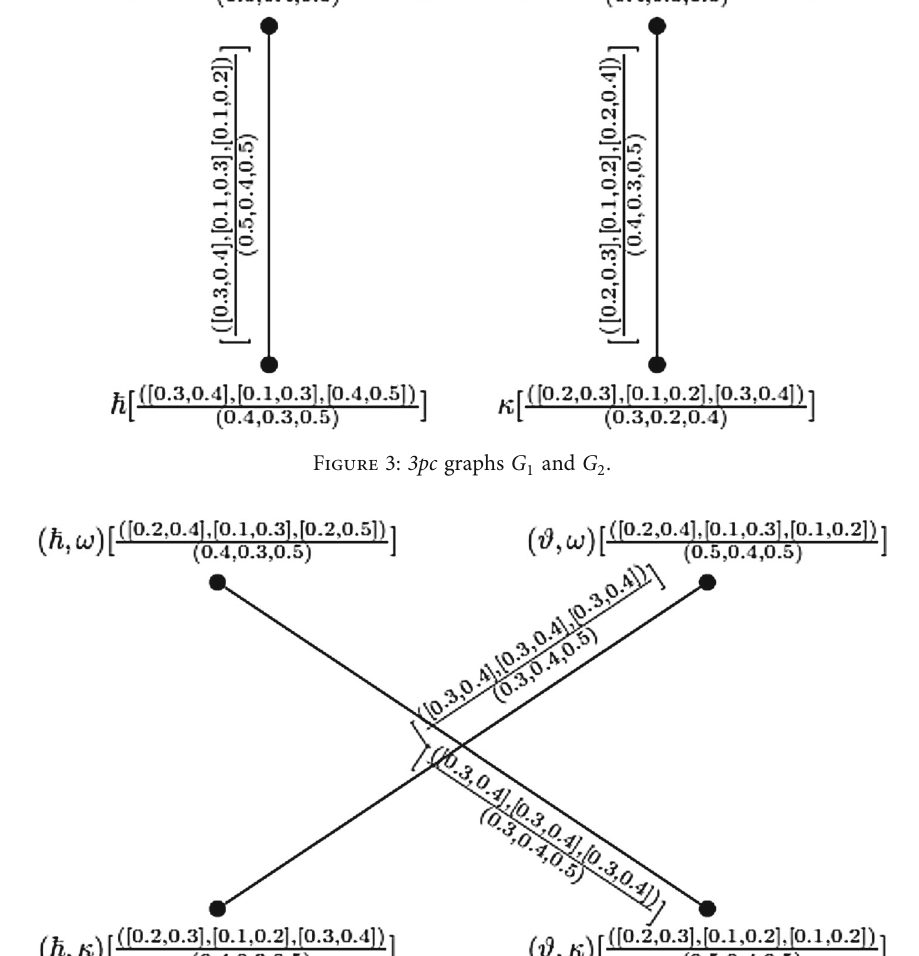
Figure 4: 3pc graph G = G